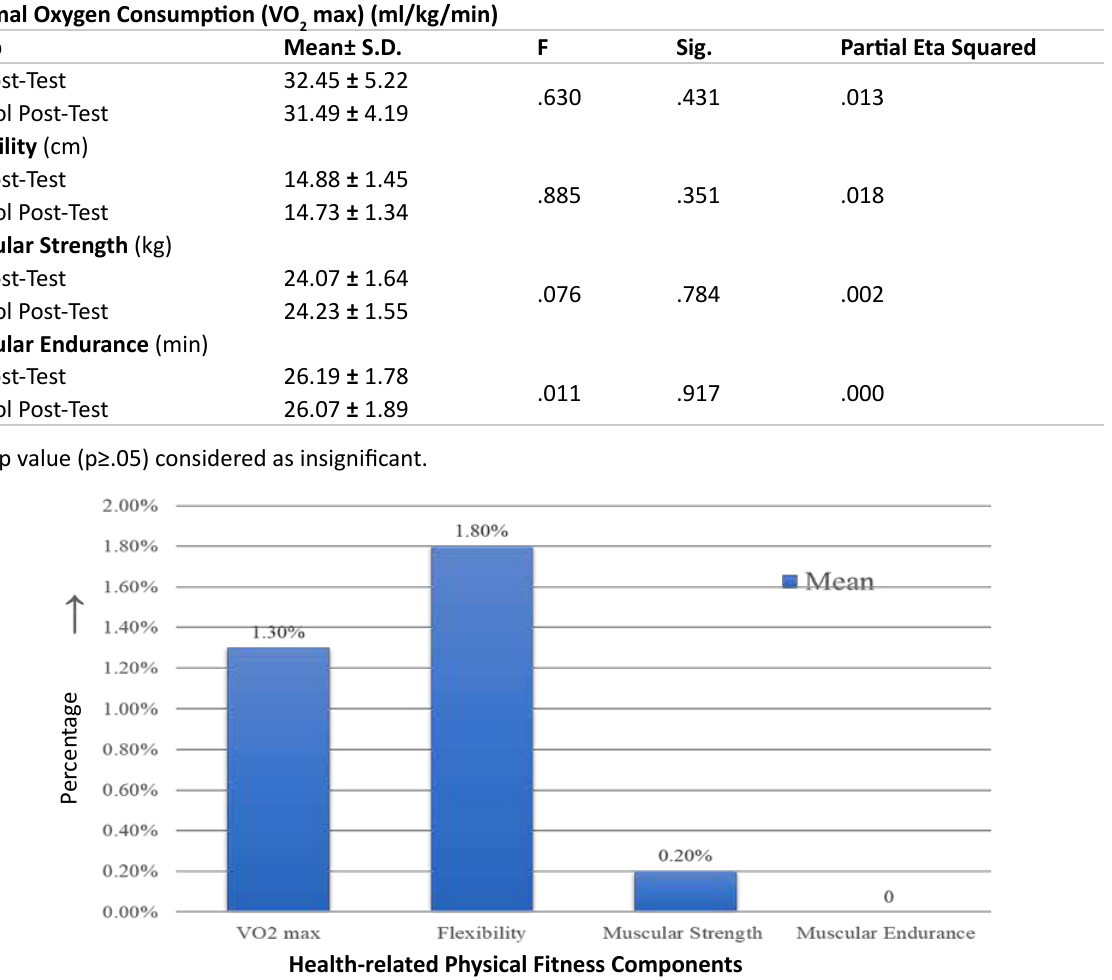
Figure 5. The increasing results in percentage % of 6-Weeks bhastrika pranayama intervention (BPI) on each variable of health-related components of physical fitness for BPI group as compared to control